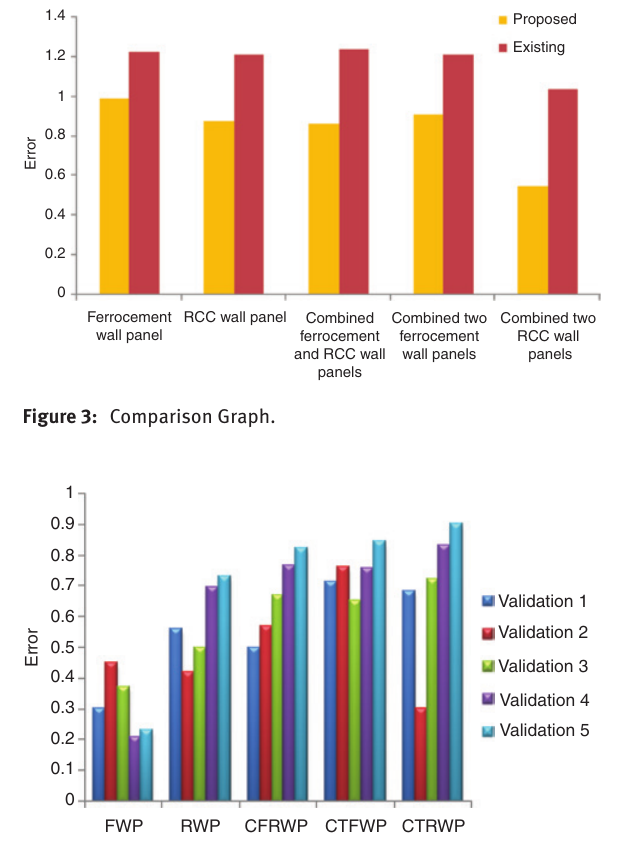
Figure 4: Validation